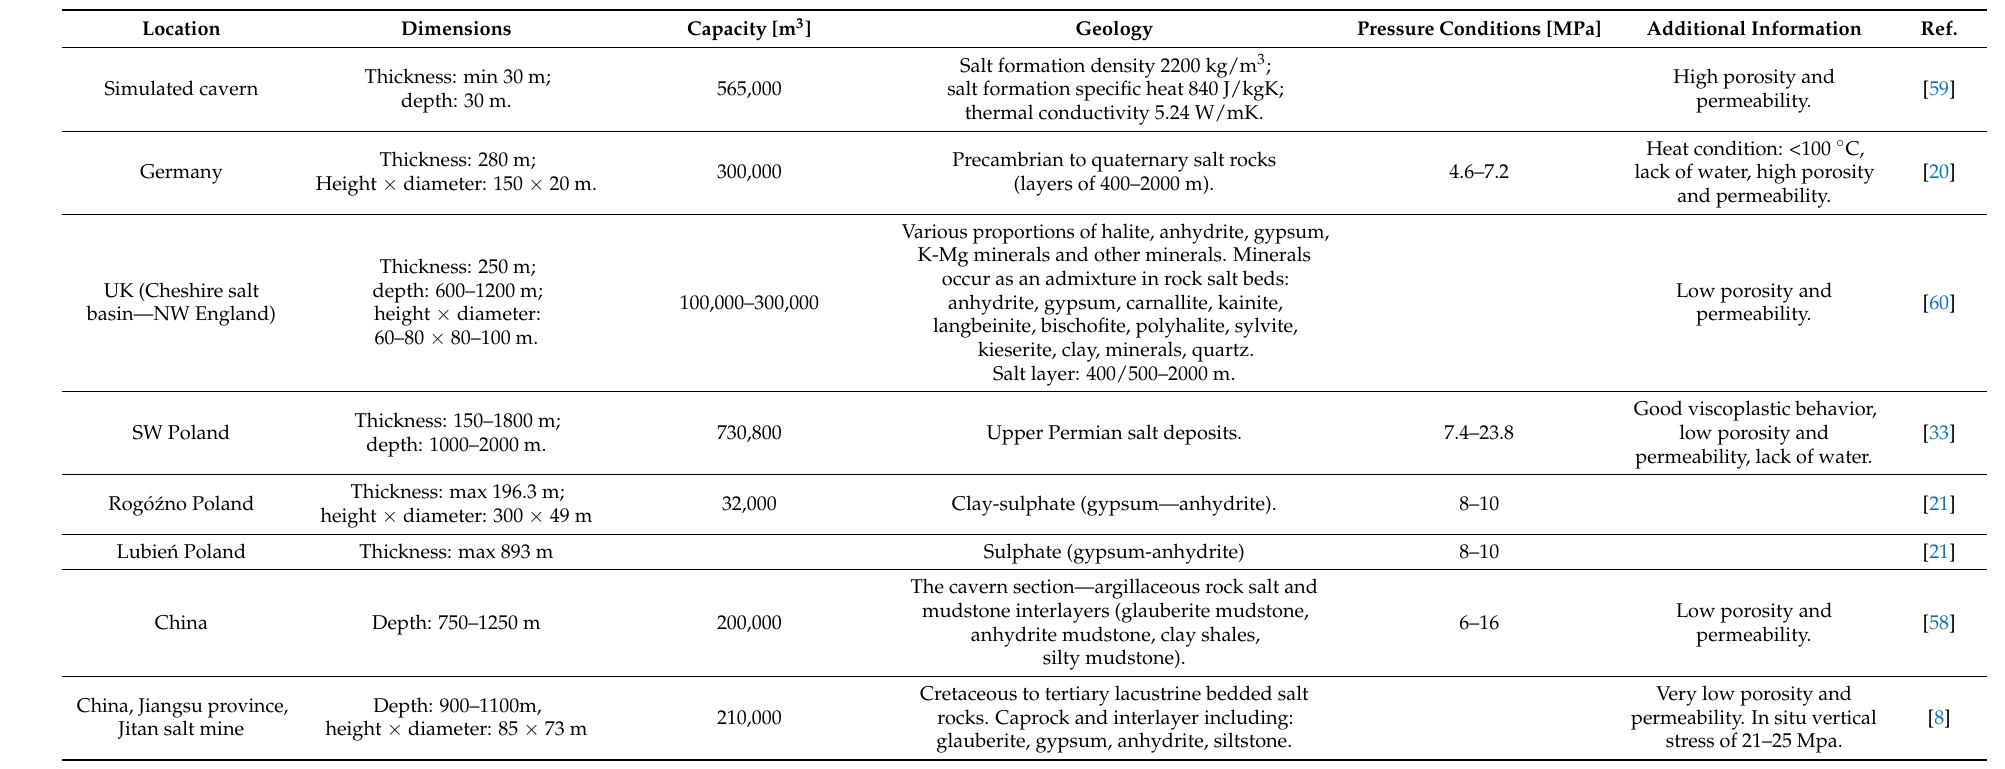
Table 5. Characteristics of prospective hydrogen salt